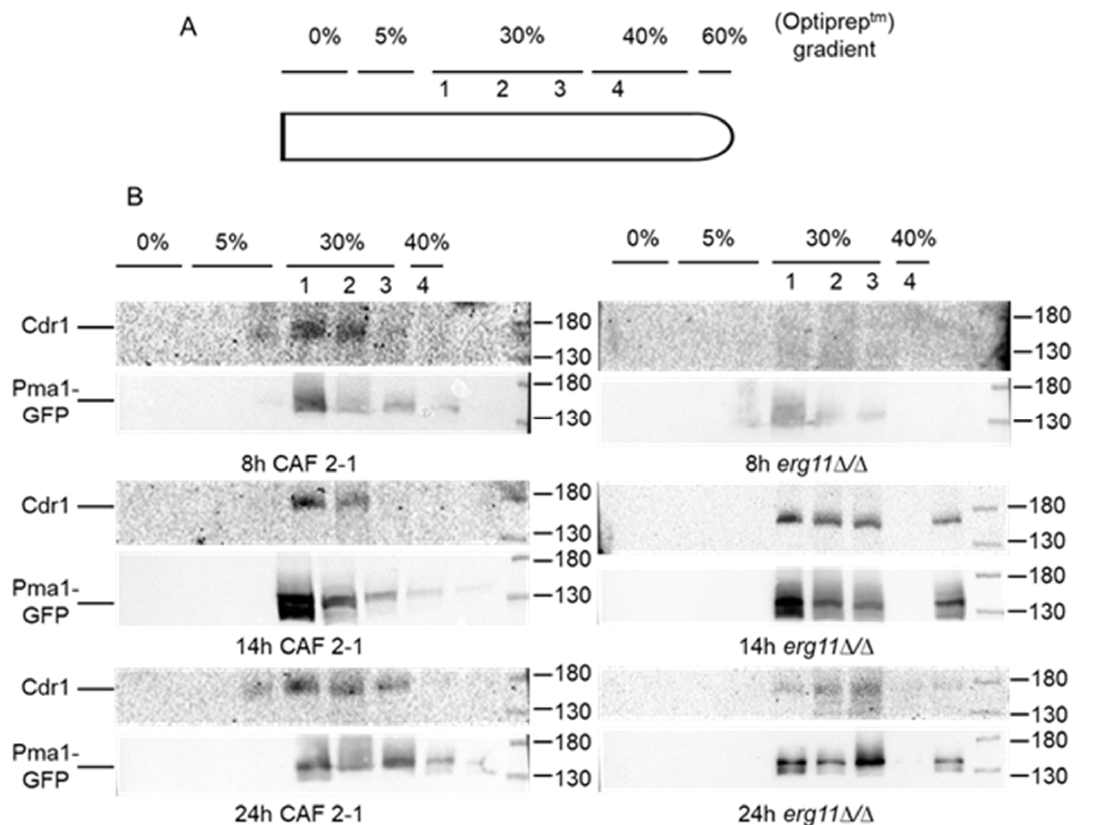
Figure 2. Immunoblot analysis of Cdr1p localization in DRMs fractions from C. albicans . ( A ) Sche- matic representation of used Optiprep tm gradient. ( B ) Wild-type CAF2-1 and ergosterol-deficient erg11 ∆ / ∆ strains were cultured for 8, 14, and 24 h in a YPD medium. Whole-cell extracts were ob- tained by glass-beads cell disruption, as described in Materials and Methods. Samples were sub- jected to Optiprep tm gradient (fractions with 0%, 5%, 30% and 40%), followed by ultracentrifugation (35,000 rpm, 17 h). Collected fractions were applied on SDS-PAGE and analyzed by western blot with anti-Cdr1 and anti-GFP antibodies.